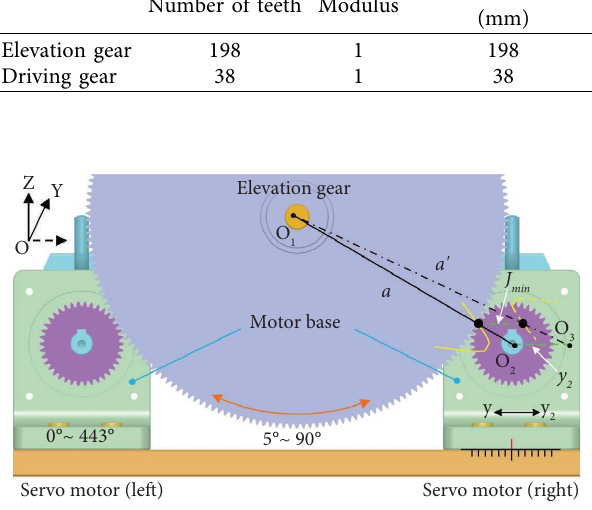
Figure 13: Te geometric relationship between J Table 3: Te corresponding relationship between y